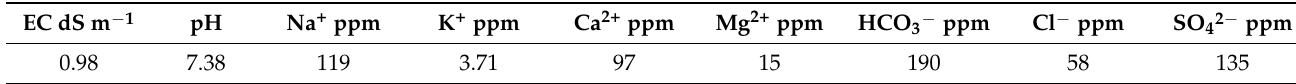
Table 4. Irrigation water analysis used for leaching to remove salinity from bovine compost.